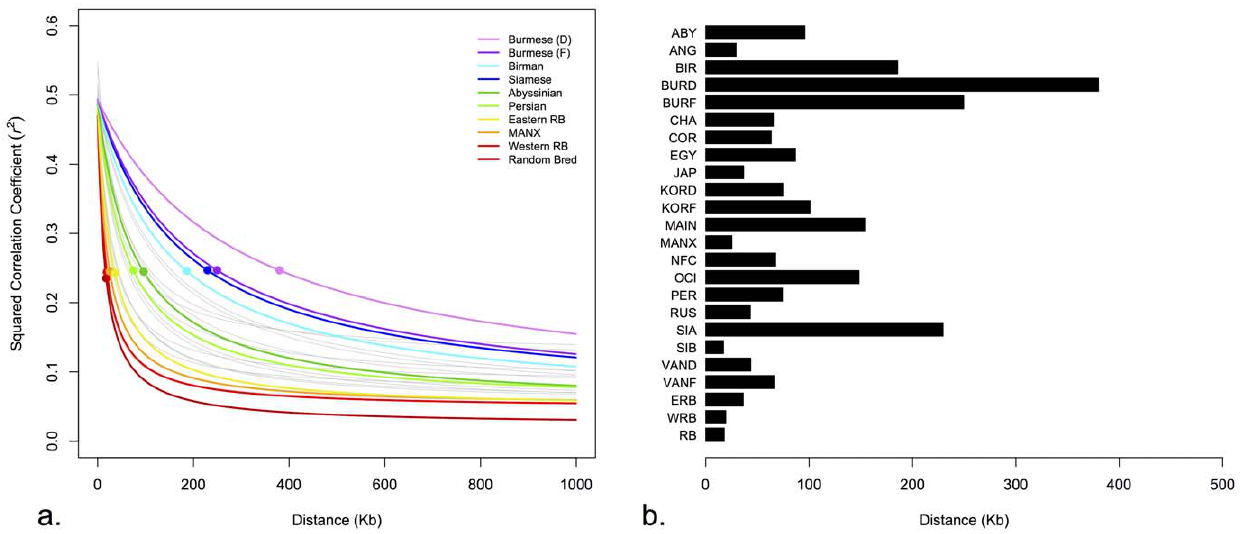
Figure 3. Extent of LD in domestic cats. a) Decay of r 2 value of autosomal chromosomes combined as a function of distance (Kb). Colored decay lines represent selected populations that depict upper, middle, and lower estimates of the LD measures. Gray decay lines represent the remaining populations. Filled circles indicate the point of 50% decay of r 2 maximum value. b) Distance in kilobases at which r 2 decays to 50% of the maximum value, which is the distance at r 2 < 0.25. The distances correspond to the filled circles in